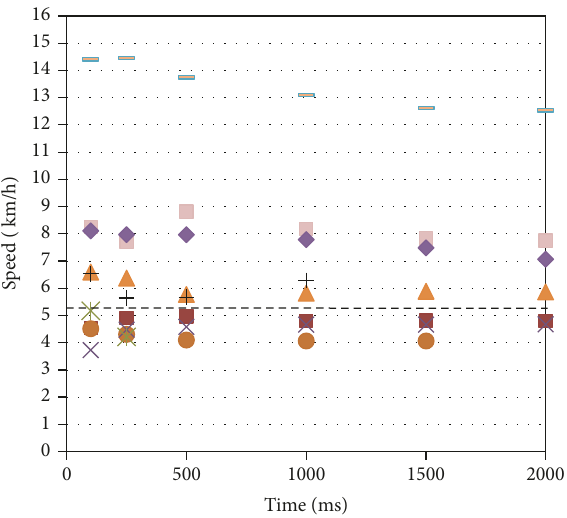
Figure 13: Estimation of the speed threshold between pedestrians and vehicles. Red squares, purple cross, and orange circles below the dashed line stand for a pedestrian. The rest are vehicles.